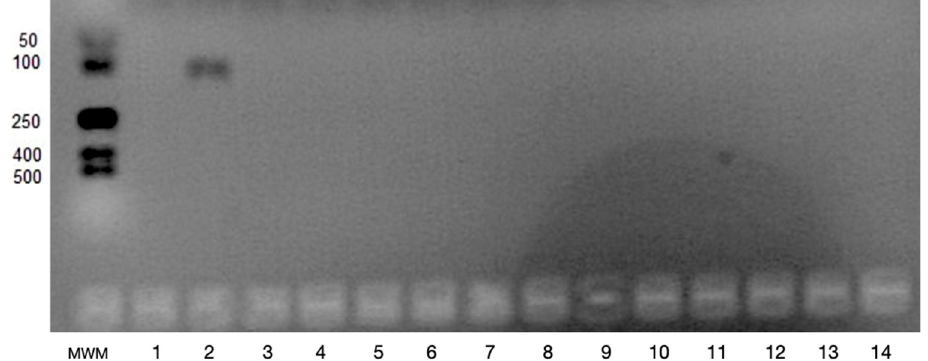
Figure 1. Example of electrophoretic separation of PCR products for VEGFA , MWM-molecular weight marker (50–500 bp); 1-negative control; 2-positive control; 3–14-samples (105 bp).